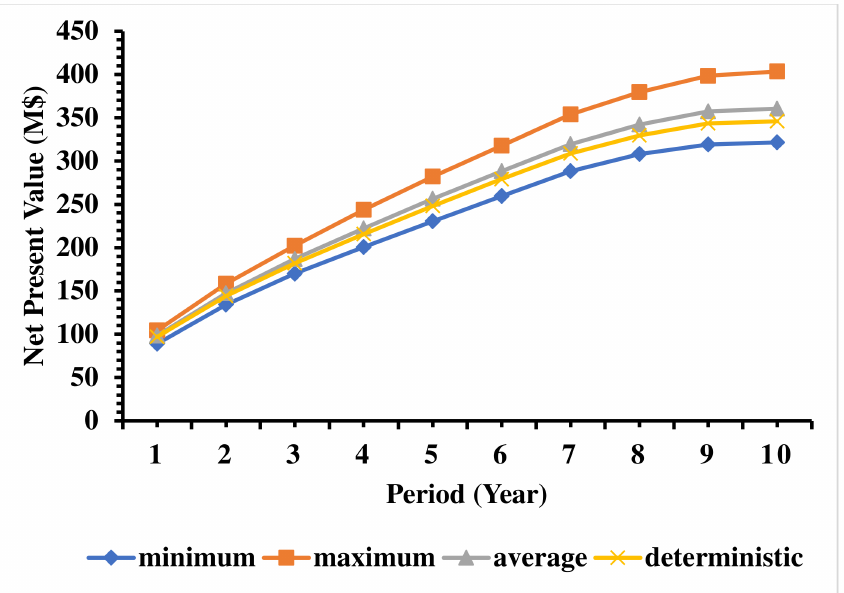
Figure 9. Comparison of cumulative discounted cash flow of the study mine using stochastic and deterministic production